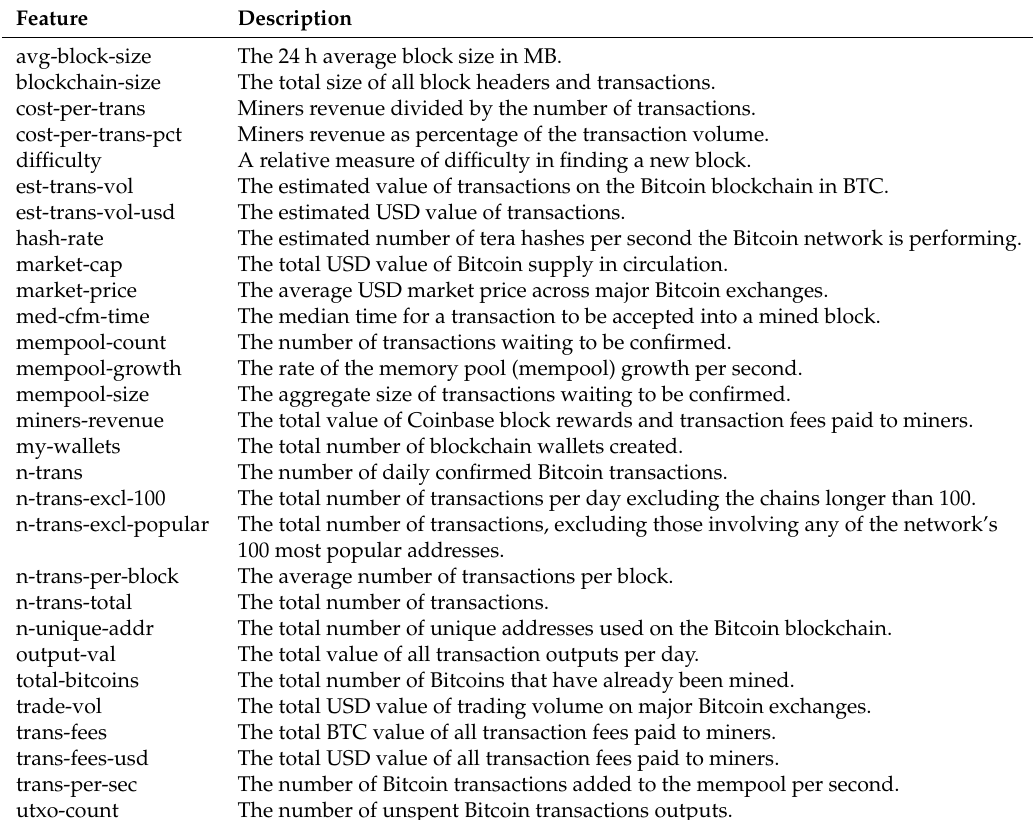
Table 1. Bitcoin blockchain features.